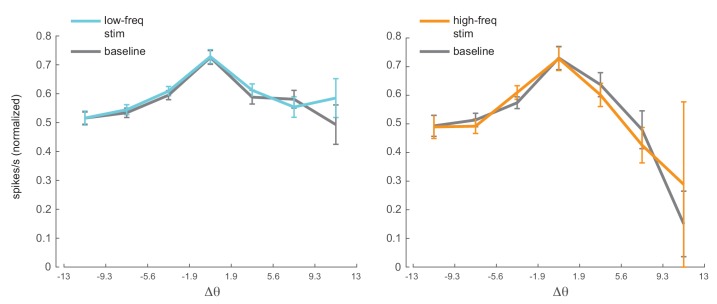
Optical stimulation does not change orientation tuning.Orientation tuning curves for the neuronal population with and without optical stimulation (left panel, low-frequency stimulation condition, n=68 units; right panel, high-frequency stimulation condition, n=25 units). The spike rates were normalized to peak response across stimulation conditions (optical stimulation and baseline no-stimulation conditions). The population tuning curves were plotted after aligning the peak response of each neuron to zero and binning the data into orientation bins. The x-axis shows the edges of the orientation bins. Mean +/- s.e.m.